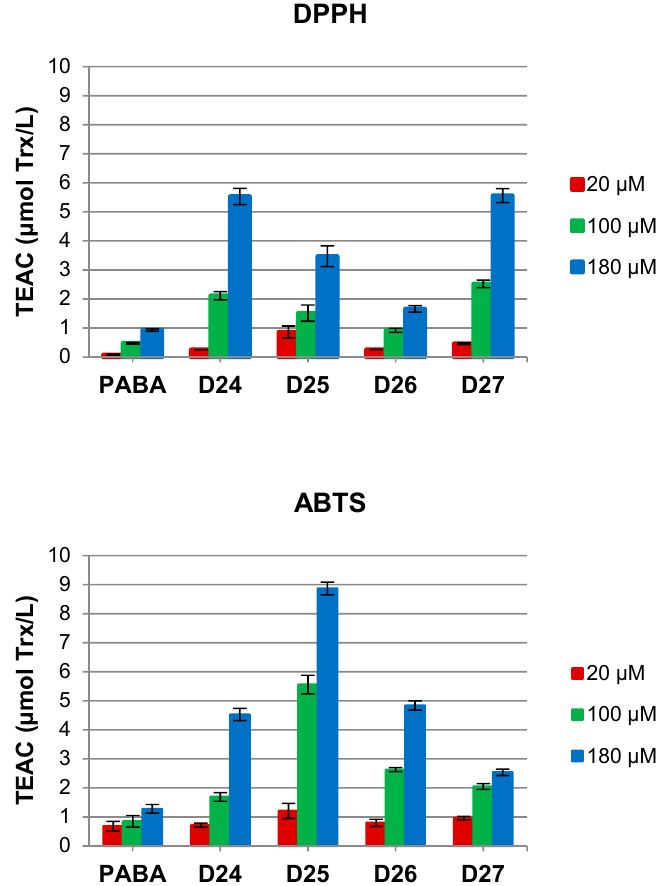
Figure 1. Antioxidant potential expressed as Trolox equivalent antioxidant capacity (TEAC) of p -aminobenzoic acid (PABA) and PABA-terminated dendrimers D24–D27 at three concentrations (20, 100 and 180 µ M) measured as neutral radicals scavenging ability (DPPH test) or cationic radicals scavenging ability (ABTS test) in relation to the known concentrations of Trolox.